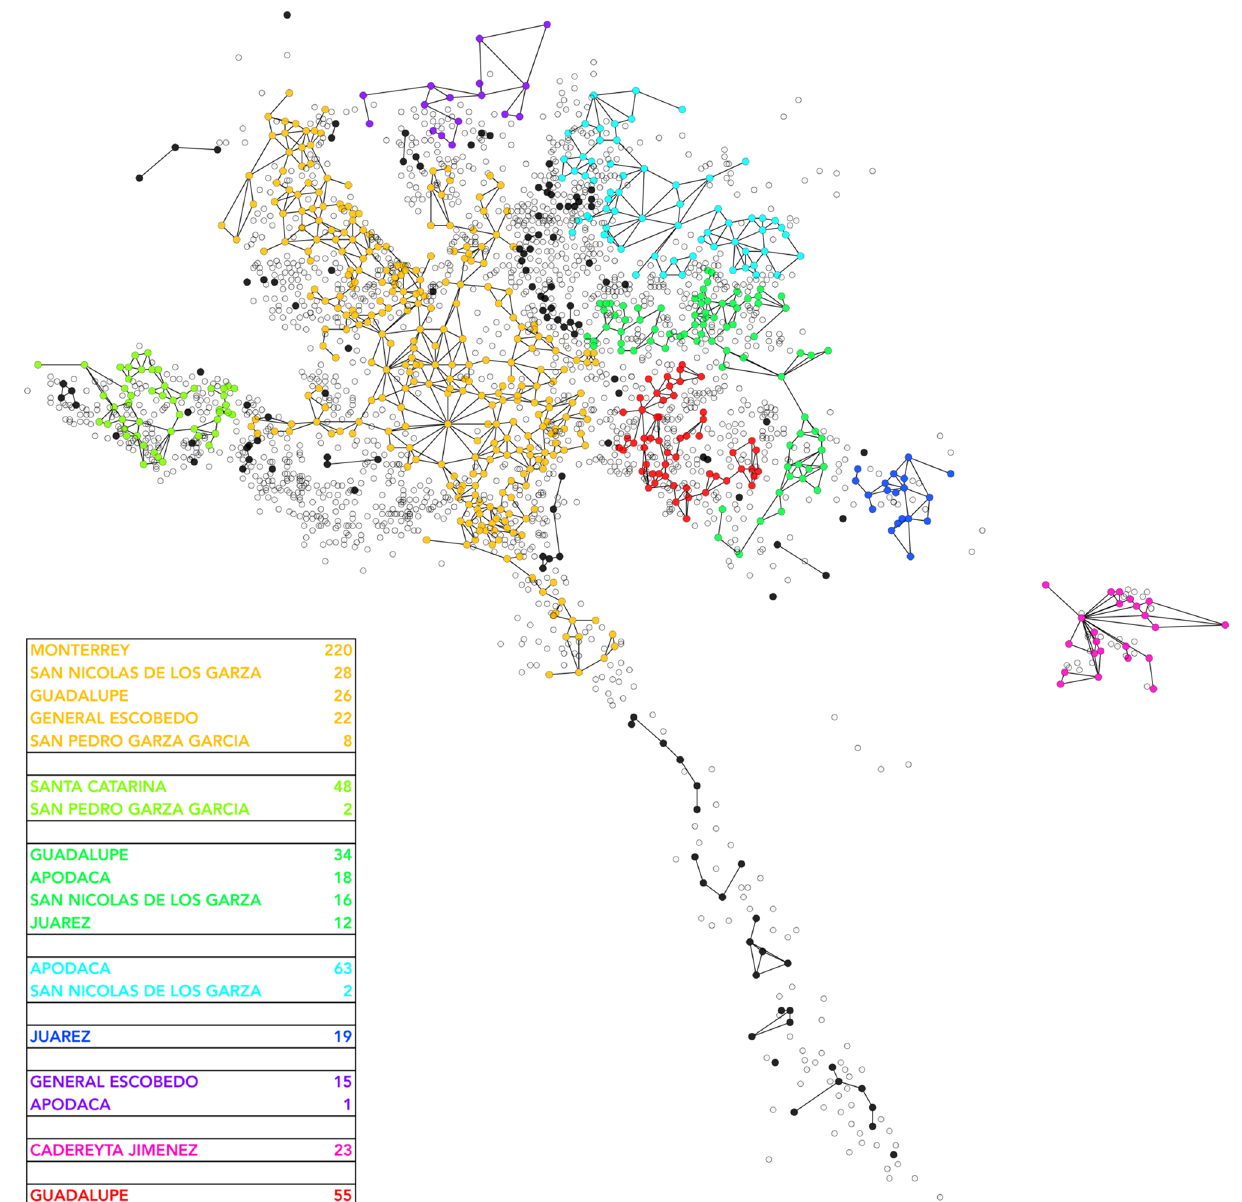
Figure 9. Network composed by adjacent violent neighborhoods during the entire period under study. Each color represents a connected component with more than 10 edges. The bottom left table indicates the municipalities that belong to each component. Black dots are neighborhoods with homicides but not connected to large